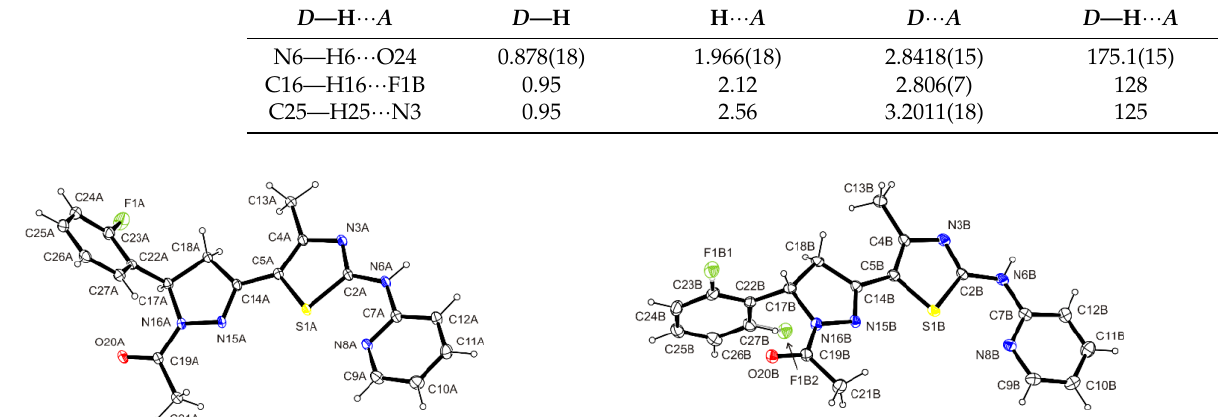
Figure 5. ORTEP view of the two symmetry-independent molecules of 6 , showing the atomic labeling scheme. Non-H atoms are drawn as displacement ellipsoids at the 30% probability level. H atoms are drawn as spheres of arbitrary radii.